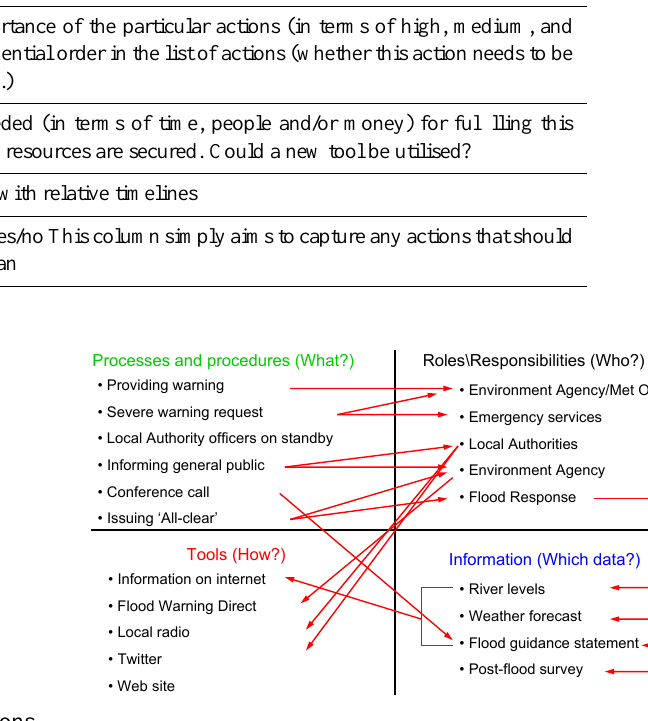
Fig. 5. Cross-table for evacuation for Sheffield developed during the workshop by the emergency managers of